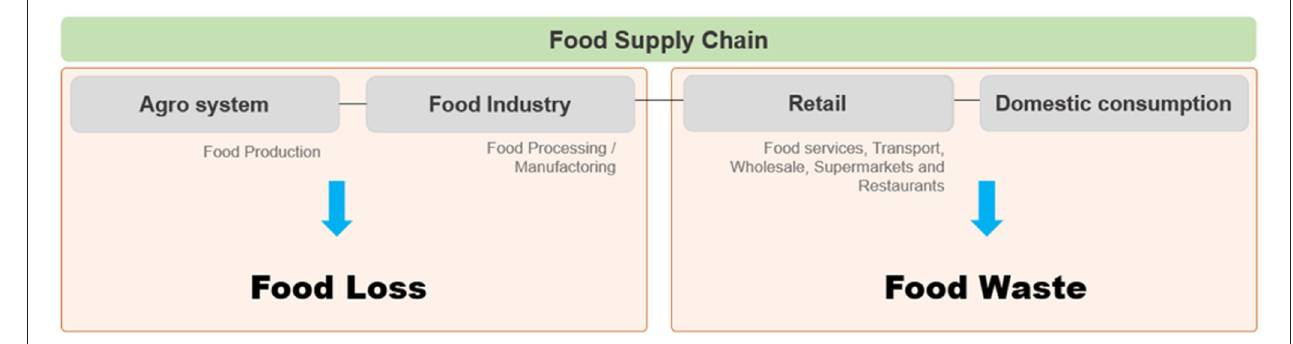
FIGURE 1 | Schema defining food loss (FL) and food waste (FW) in the food supply chain. Teuber and Jensen (28), with adaptions.